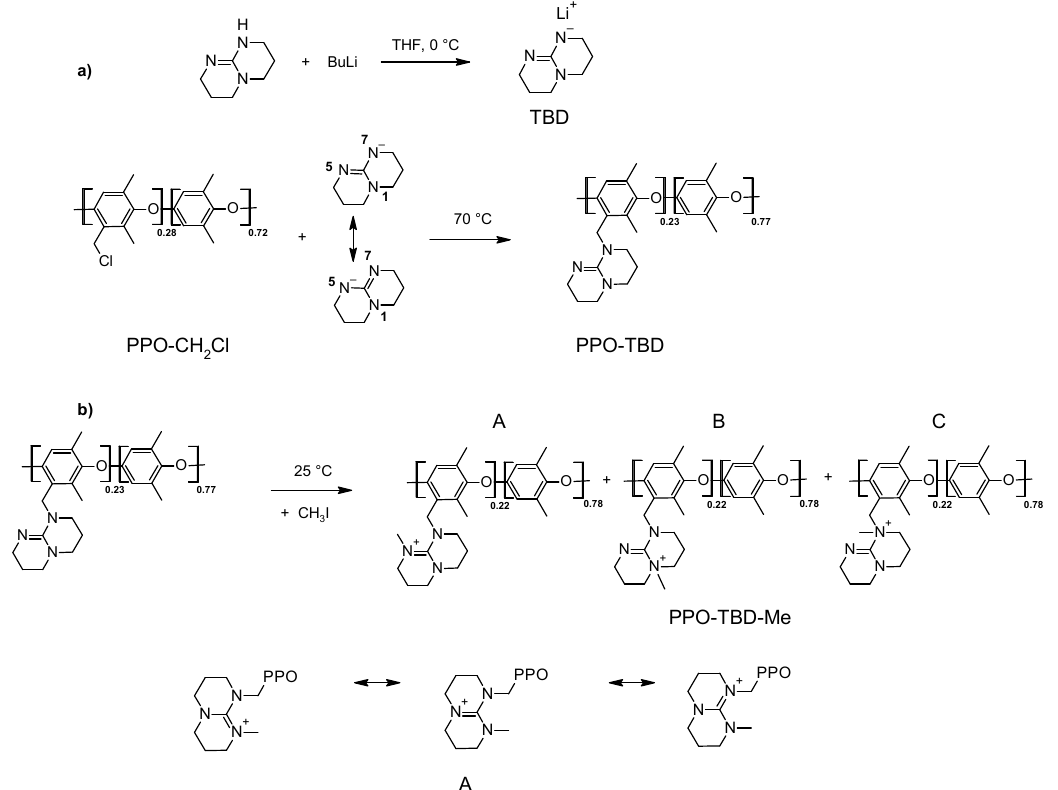
Figure 1. Reaction pathways for the synthesis of ( a ) PPO-TBD and ( b ) PPO-TBD-Me. The different PPO-TBD-Me isomers (A, B, and C) are represented together with the mesomeric formulas of the isomer A.